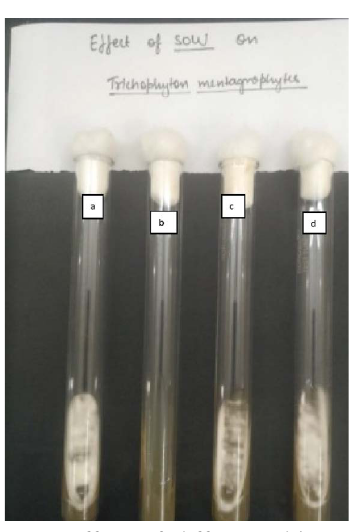
Fig. 1 . Effect of different dilution of SOW on T.mentagrophyte. (a): control tube; no exposure to SOW, (b) no growth after exposure to undiluted SOW, (c) growth after exposure to 5 times diluted SOW, (d) growth after exposure to 10 times diluted